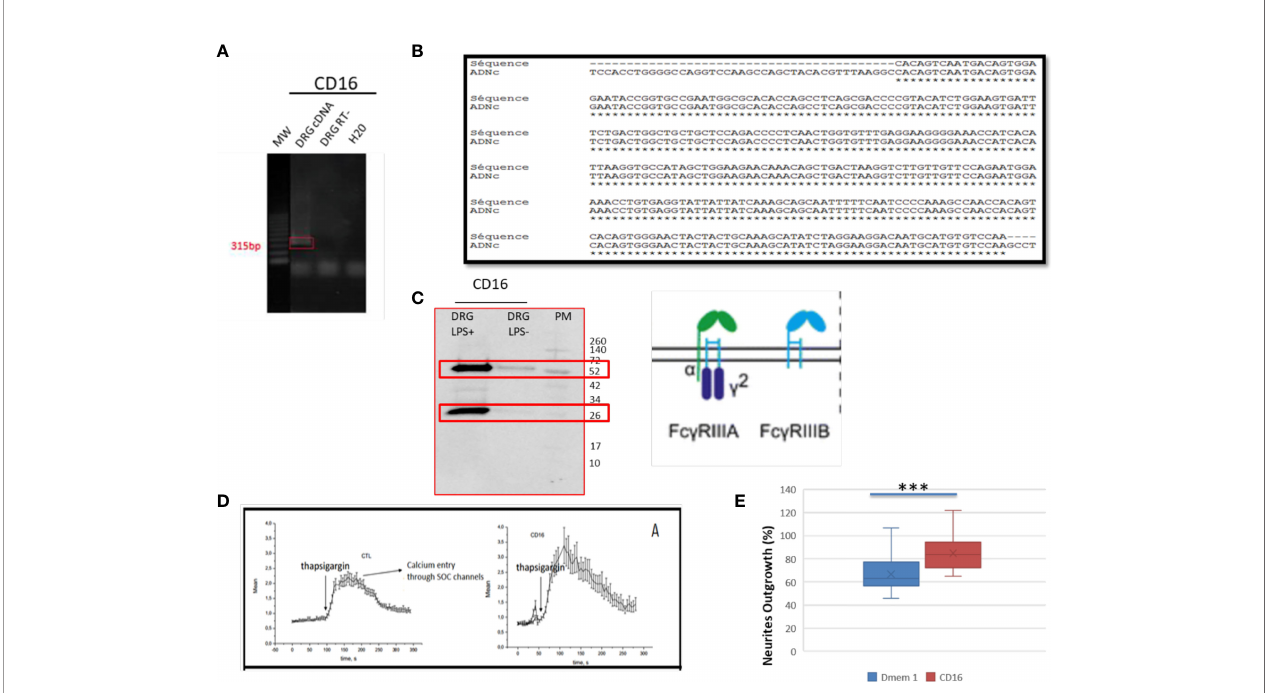
FIGURE 6 | Identi fi cation of Fc g RIII receptors in sensory neurons. (A) RT-PCR ampli fi cation of Cd16 mRNA. (B) Sequence alignment of the nucleic acid sequence. (C) Western blot analysis to detect CD16 in DRG cells treated with LPS. (D) CD16 activation by speci fi c antibody in TG-activated SOCE conditions impacts Ca 2+ homeostasis. Quanti fi cation of the results are presented in the left panel for the controls and in the right panel for CD16 activation. (E) Neurite outgrowth in DRG ND7/23 cells in the presence of anti-CD16 activating CD16. ***P value of <